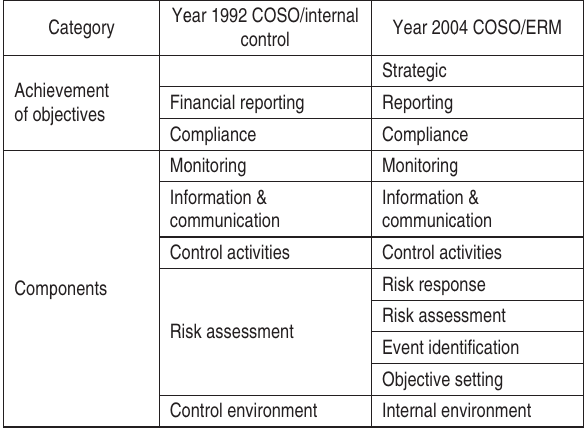
Fig. 1. ER 2.1. Integra